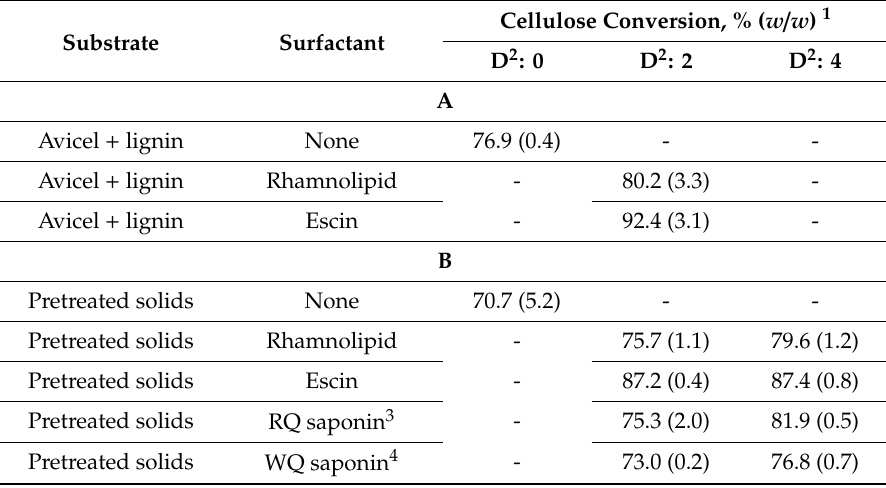
Table1. CelluloseconversioninenzymatichydrolysisofAvicel / ligninmixtures(A)andsteam-pretreated spruce (SPS) (B) in the presence of